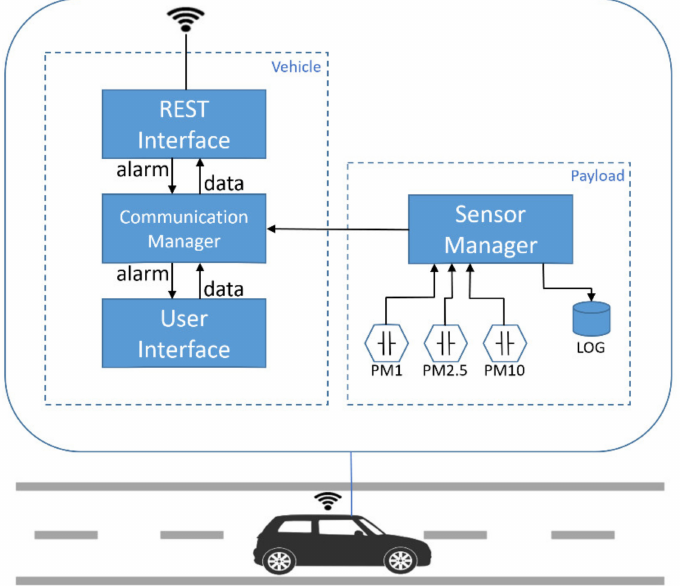
Figure 2. The Smart Road: a vehicle may carry on a dialogue with the city by exchanging data and alarm